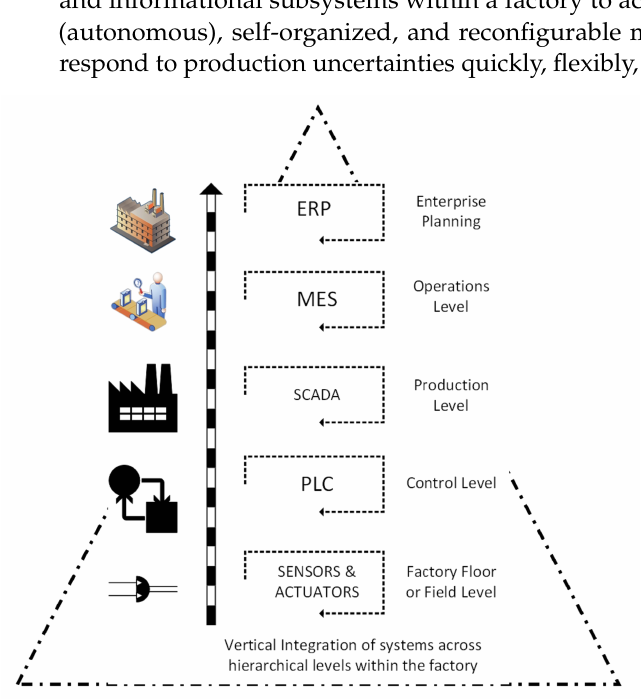
Figure 5. Automation